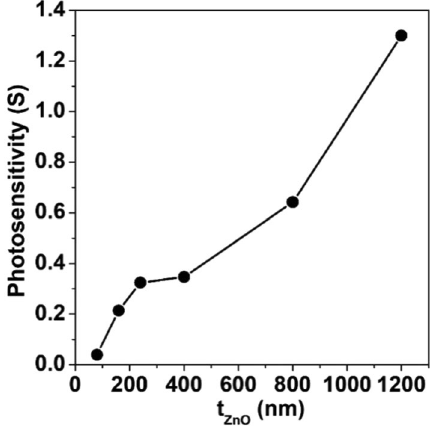
Fig. 6 Photosensitivity of ZnO thin films as a function of t